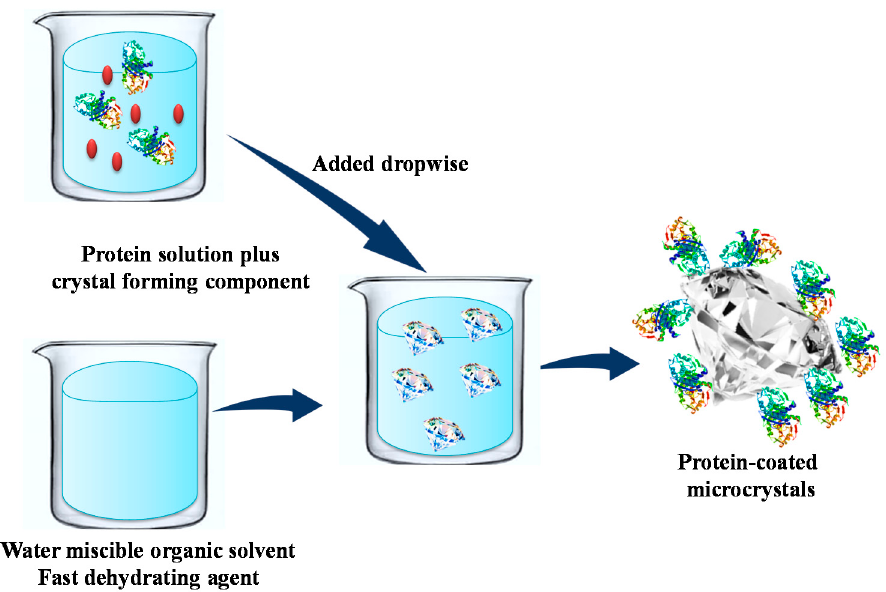
Figure 6. Schematic representation of enzyme immobilization via protein coated microcrystals strategy (PCMC).